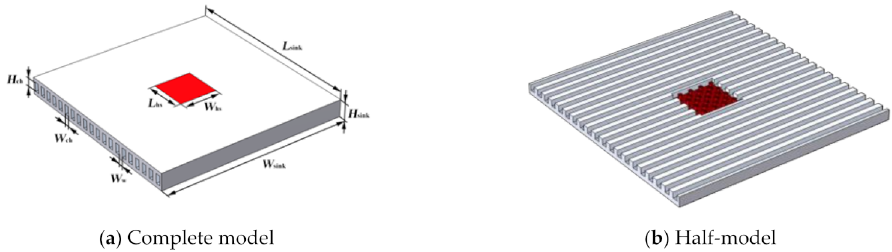
Figure 2. Geometric model of microchannel pin-fin hybrid heat sink [9]. ( a ) Complete model of heat sink. ( b ) Half-model of heat sink.